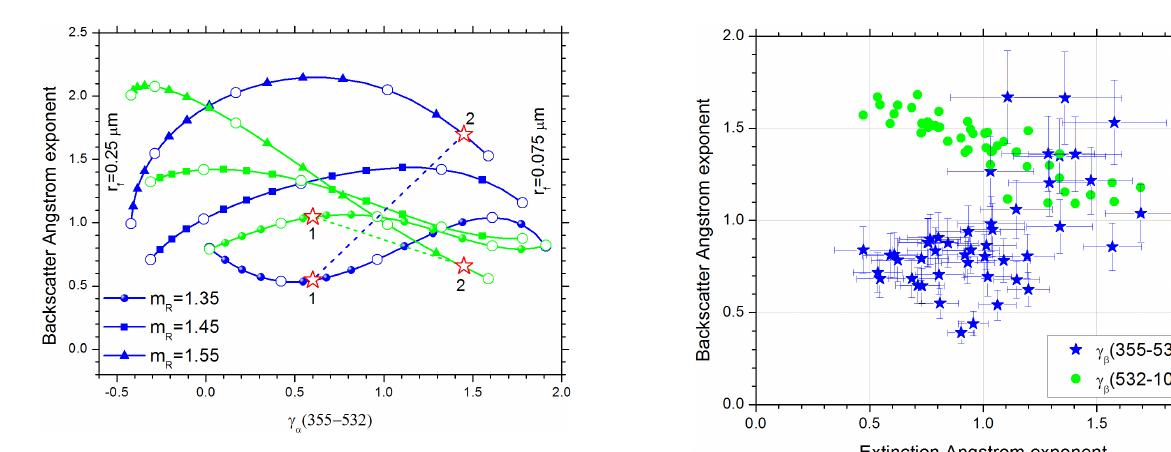
Figure 20. Backscatter Ångström exponents γ β (355–532) (blue) and γ β (532–1064) (green) vs. γ α (355–532) for R N = 10 4 and r f varied in the range 0.075–0.25µm. Results are given for m R = 1 . 35, 1.45 and 1.55; the imaginary part is m I = 0 . 005 for all curves. Open circles mark the points corresponding to r f = 0 . 075, 0.1, 0.15, 0.2 and 0.25µm. Dash lines show the “trajectories” when parti- cle parameters change from r f = 0 . 18µm, m R = 1 . 35 (1, star) to r f = 0 . 085µm, m R = 1.55 (2, star).